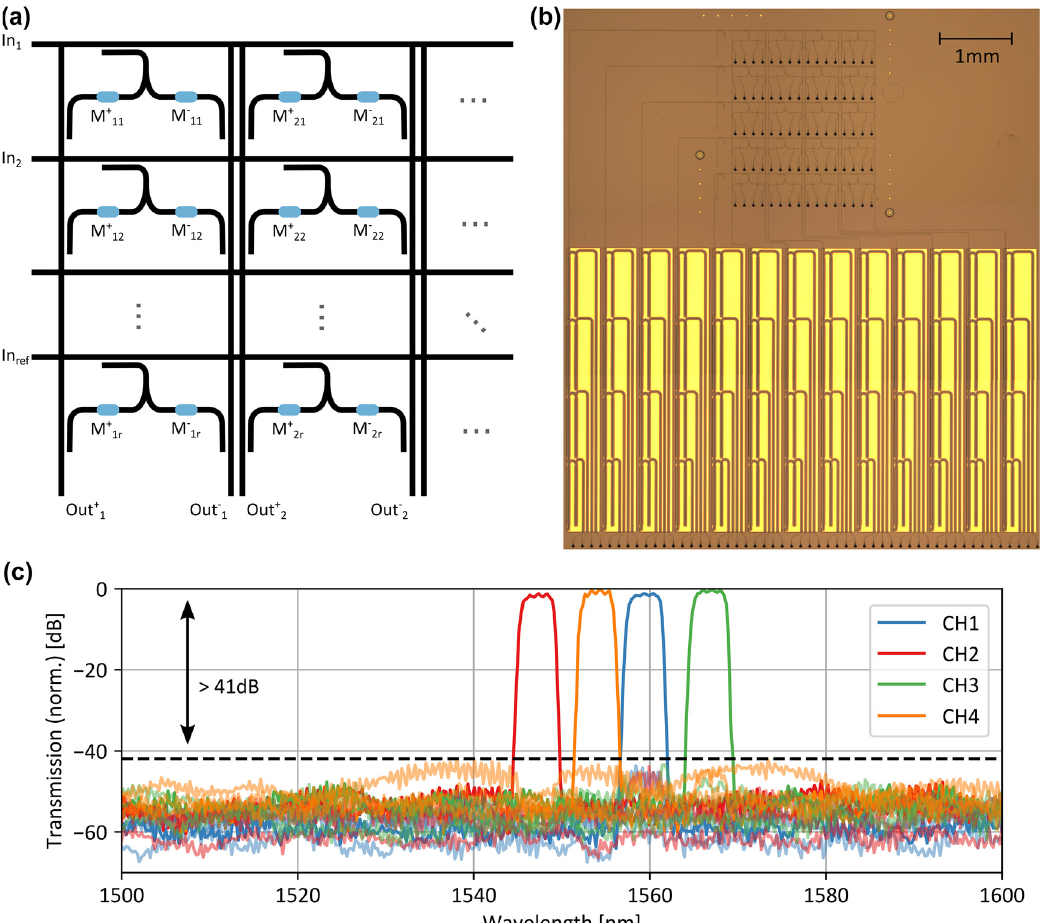
Figure4: Wavelength multiplexed photonicscrossbararray.(a) Sketchof thephotoniccrossbararray. The vectorcomponentsareencodedin laser pulses of different power and sent in the horizontal input waveguides. An additional reference computation row is added to allow for negative valued input vectors. At the output balanced detection is performed between the positive and negative output of each column. (b) Fabricated photonic circuit. We fabricate the photonic crossbar array connected to the MUX and DEMUX unit silicon nitride platform. (c) Measured wavelength channels. The full colored lines show the transmission from the input wavelength channel to the same output wavelength channelthroughthecompletesystem.Thelight-colored linesfrom theinputchanneltothe otherthreewavelength channels.Due to the double cascading of the add – drop filters in the multiplexer, we achieve a channel crosstalk below − 41